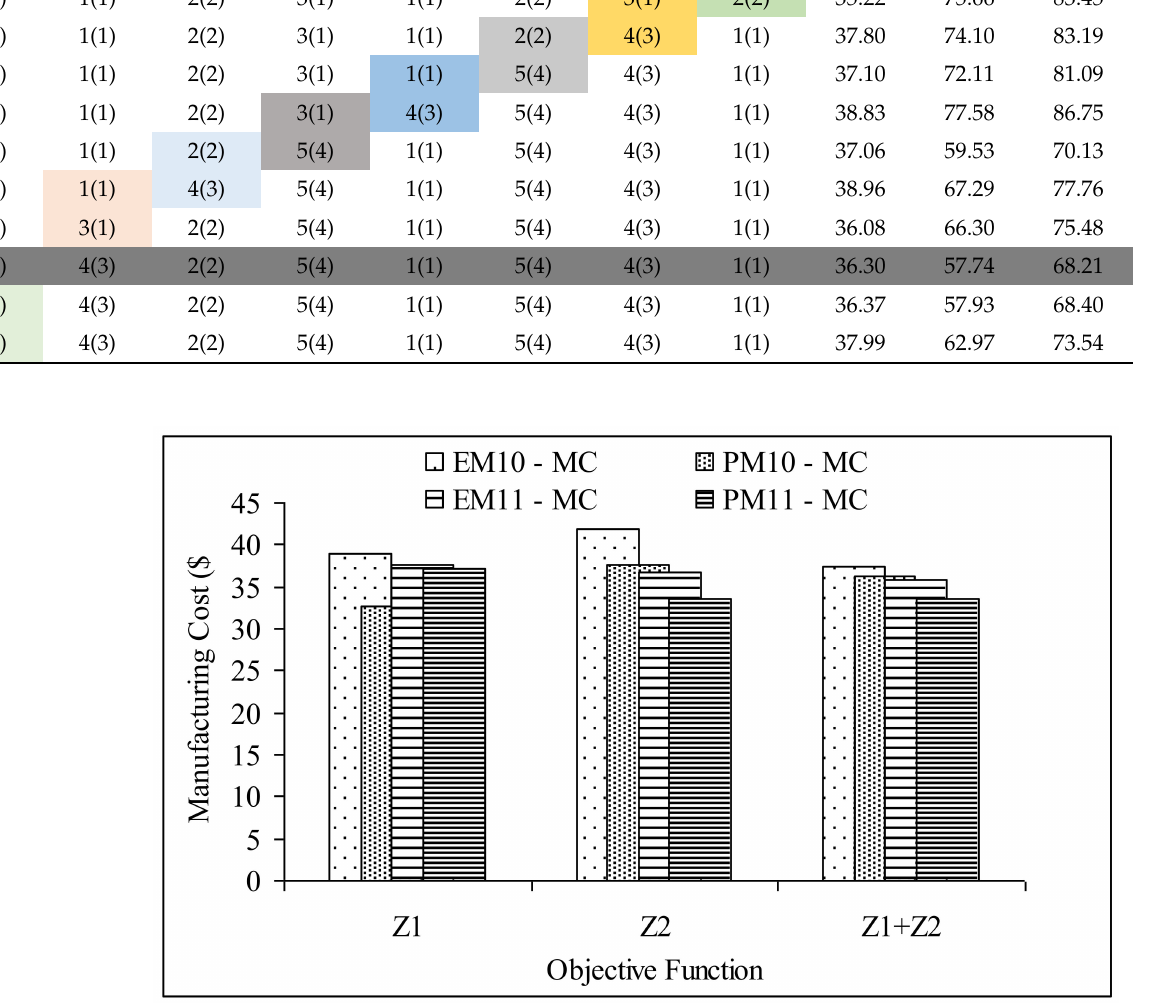
Figure 6. Comparison of tolerance cost of the proposed method with the existing problem presented in Geetha et al. (2013) MC: tolerance cost; EM10 & EM11: existing method, as per data presented in Tables 10 and 11 of Geetha et al.; PM10 & PM11: proposed method, as per data presented in Tables 10 and 11 of Geetha et al.